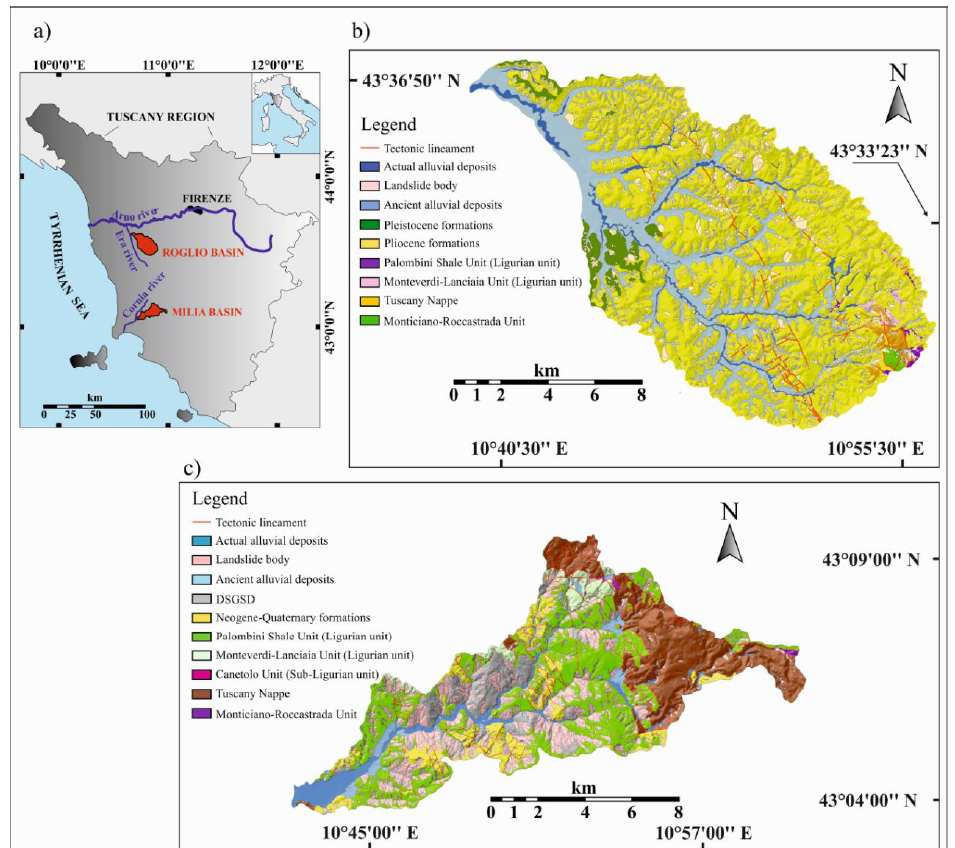
Figure 1. Location of the study areas ( a ) and the geological characteristics ( b , c ).